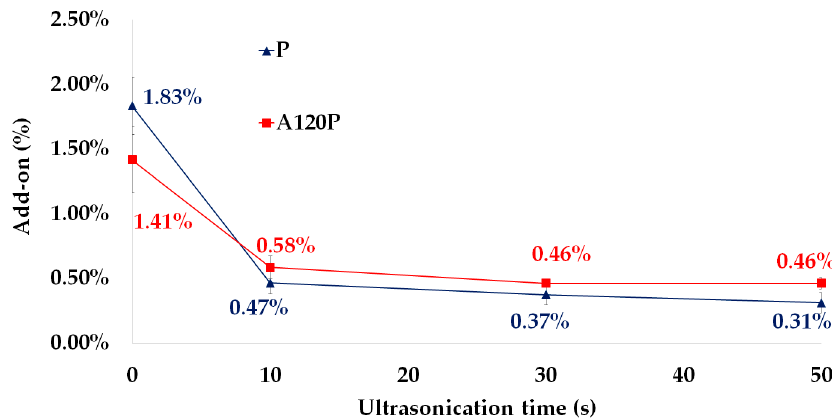
Figure A1. FT-IR spectra of PVDF films treated with an NaOH solution for 0 min (UT), 60 min (A60), 120 min (A120), and 180 min (A180) for the range of 700–1400 cm − 1 ( a ), 1450–2000 cm − 1 ( b ), 1400–4000 cm − 1 ( c ).